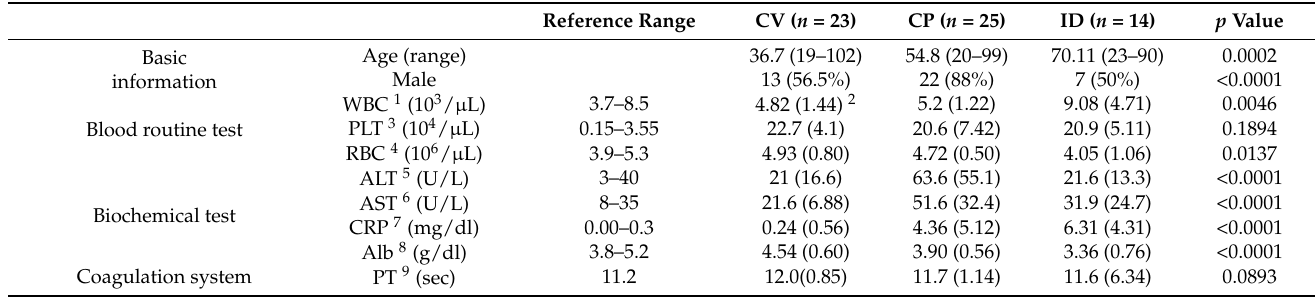
Table 1. Patient demographics.